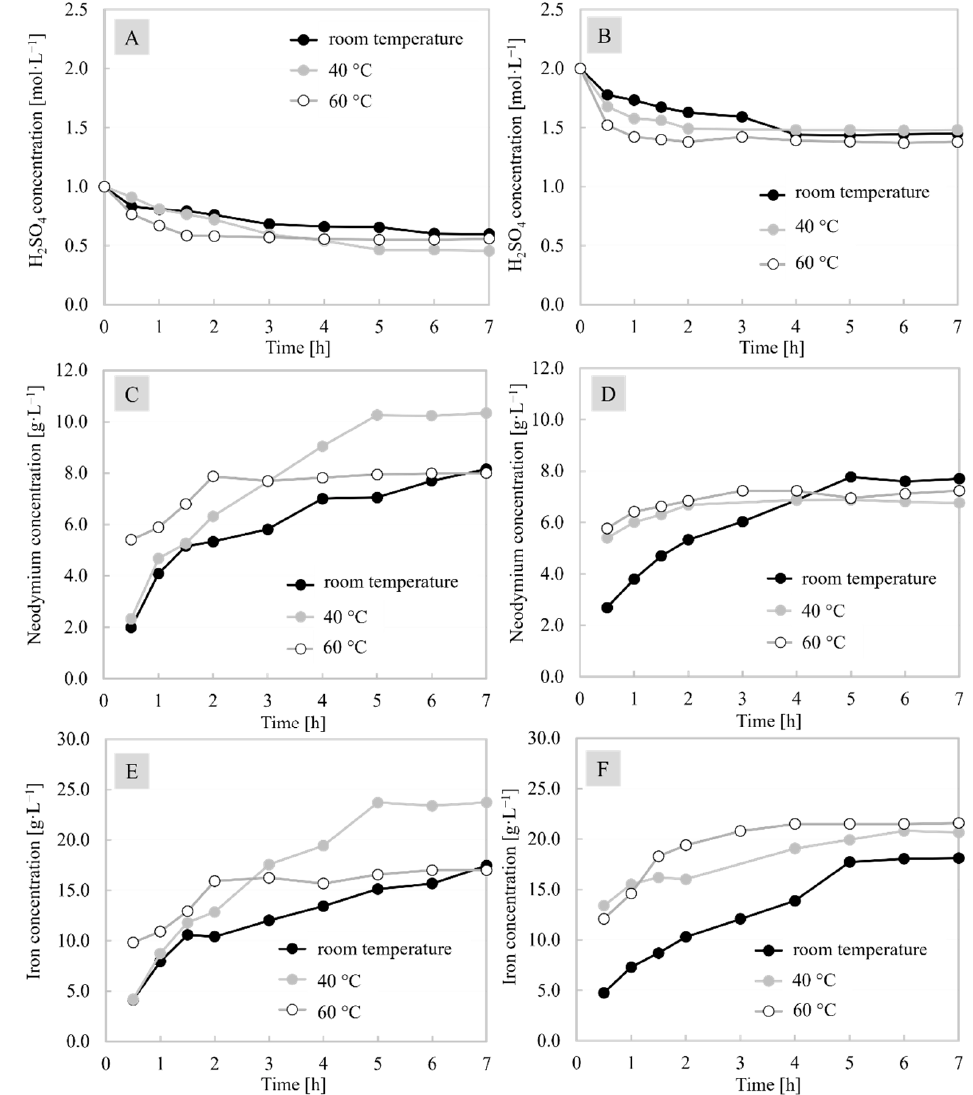
Figure 5. Leaching of the whole (non-demagnetized) NdFeB magnets in 1 M H 2 SO 4 solution (left side) and 2 M H 2 SO 4 solution (right side). Different figures show the dependence between leaching time and the concentration of H 2 SO 4 ( A , B ), neodymium ( C , D ) and iron ( E , F ).